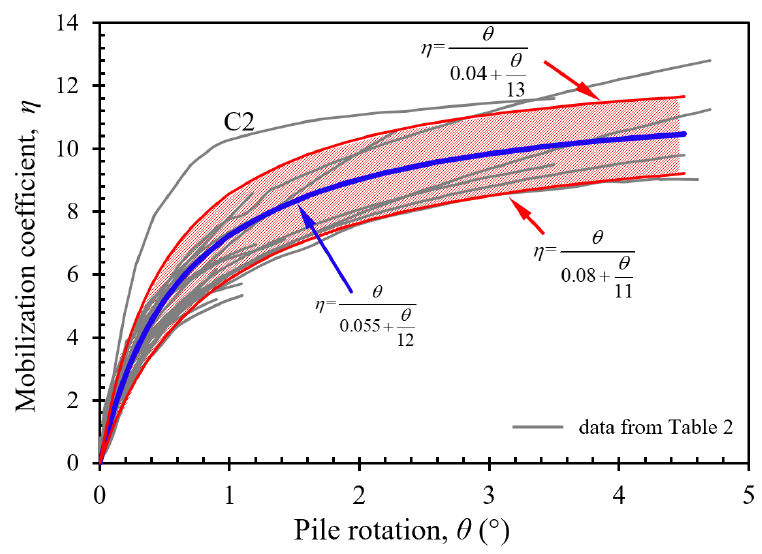
Figure 7. Correlation between monopile rotation and mobilization coefficient of soil resistance. Based on the fitted correlations between the mobilization coefficient and pile rotation, the values of η max mainly range from 9.9~11.7 (assumes that R f = 0.9), which agree with the limit value of N p as illustrated in Figure 3. In order to estimate the value of K ini in Equation (6), the derived value of K ini is plotted with soil rigidity factor K (= E s /S u ) for each pile test, see Figure 8. For simplicity and to reduce the effect of maximum mobilization coefficient η max and soil failure ratio R f , a constant value of 12 is set for the ratio of η max to R f .